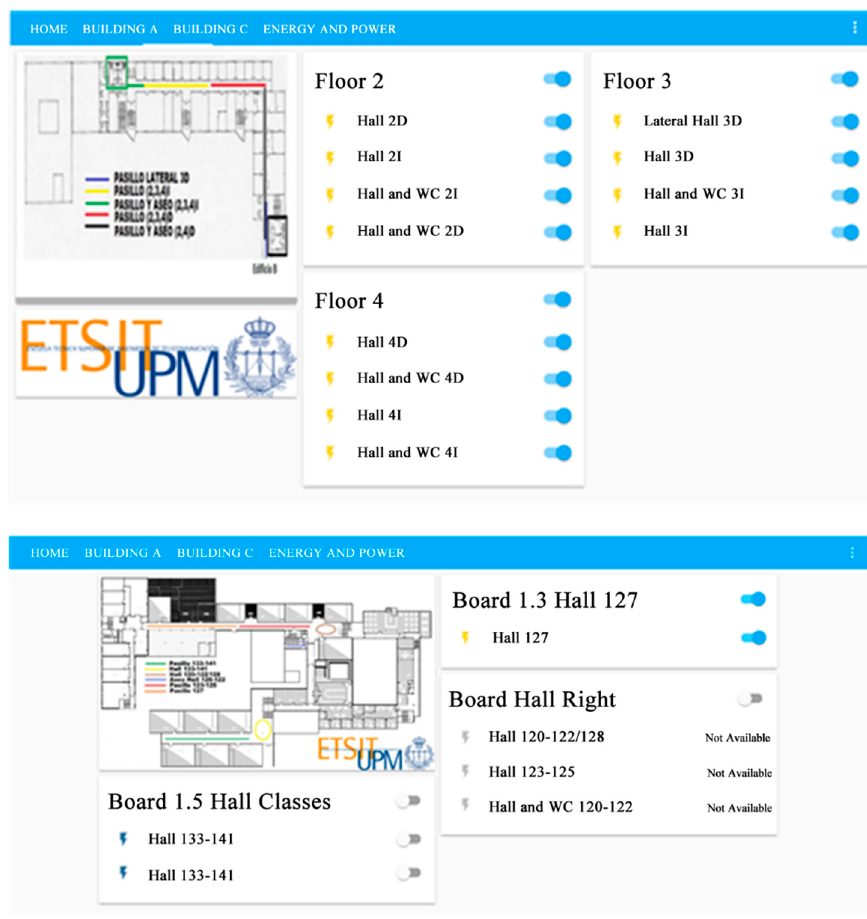
Figure 13. Web interface of home assistant .